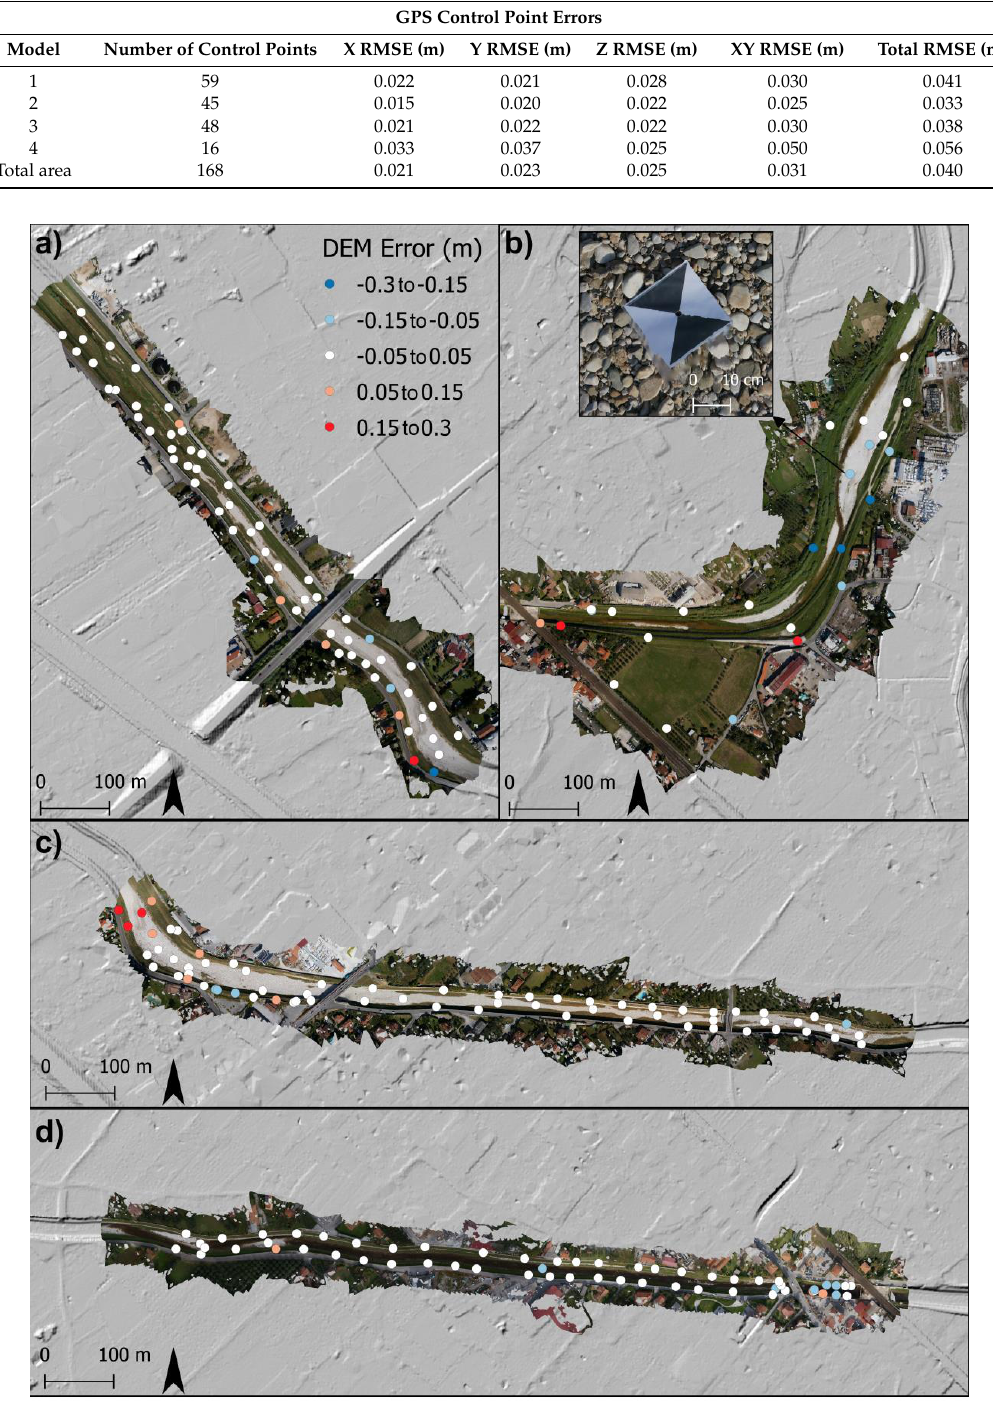
Figure 3. Spatial distribution of the GCPs used for the model construction (see Tables 2 and 3). Color coding refers to all the models and shows the vertical differences between DEM and GCP elevation. ( a ) Model 1; ( b ) model 4, inset shows an example of the targets captured in the images; ( c ) model 2; and ( d ) model 3.